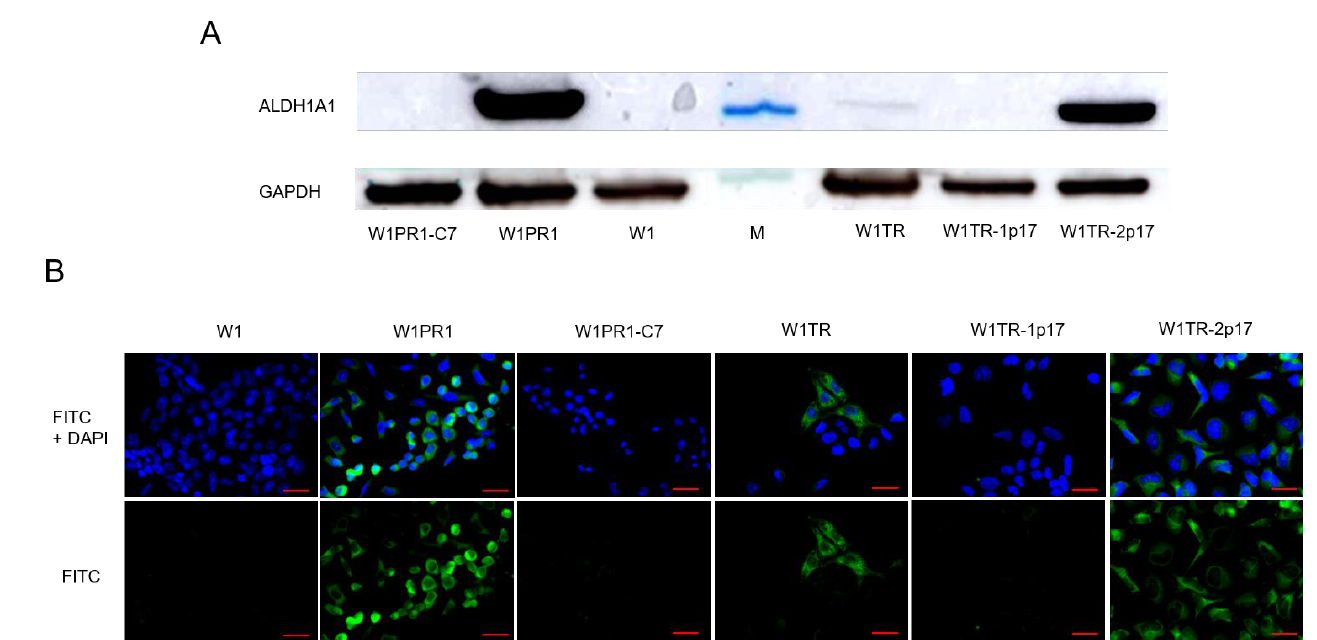
Figure 2. ( A ) ALDH1A1 protein expression analysis in the W1 drug-sensitive cell line and drug resistant W1PR1, W1PR1-C7, W1TR, W1TR-1p17, W1TR-2p17 cell lines. The cellular proteins were separated using 7% PAGE and transferred to a nitrocellulose membrane, immunoblotted with a primary antibody (Ab) and HRP-conjugated secondary Ab. A primary anti-GAPDH Ab served as a loading control for the cell lysates; M-protein molecular weight marker ( B ) Immunofluorescence visualization of ALDH1A1 expression in the W1 drug-sensitive cell line, drug resistant sublines and CRISPR-Cas9-edited variants. ALDH1A1 was detected using the anti-ALDH1A1 Ab and an Alexa Fluor ® 488-conjugated secondary Ab (green). DAPI was used to counterstain nuclei (blue). Objective 40×. Scale bar = 20 µm.